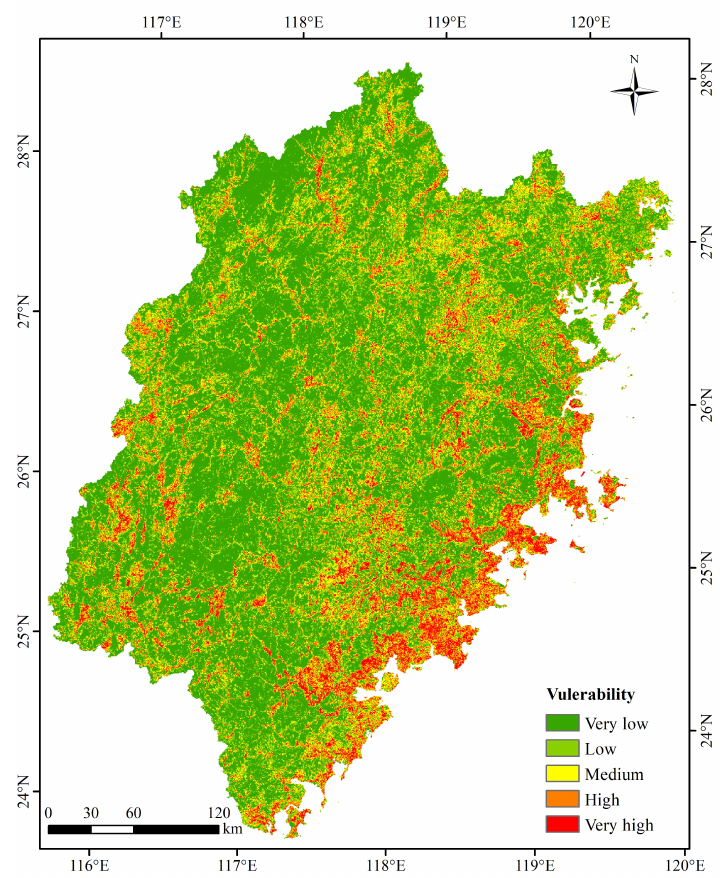
Figure 7. Spatial distribution characteristics of